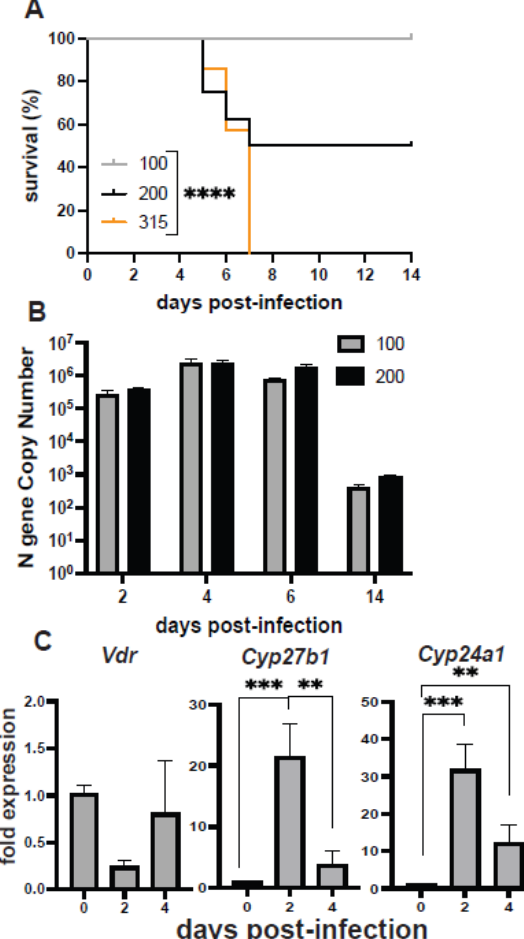
Figure 2. SARS-CoV-2 infection. K18-hACE2 mice were intranasally inoculated with 100 ( n = 8), 200 ( n = 8), and 315 ( n = 7) TCID 50 of SARS-CoV-2 virus. Mice were sacrificed when they met pre-determined endpoints (worsening conjunctivitis, lethargy, labored breathing, and/or dehydration) or at day 14 post-infection. ( A ) Mice were monitored for survival until day 14 post-infection. Mice were euthanized, and lung tissue was collected for ( B ) SARS-CoV-2 N gene expression at days 2–14 post-infection, ( C ) Vdr, Cyp24A1 , and Cyp27B1 mRNA gene expression ( n = 4/group/timepoint) at day 0, day 2, and day 4 post-infection in the lung. Samples were normalized to uninfected control tissue. Values are the mean ± SEM. Statistical significance was assessed using log-rank test for trend ( A ), two-way ANOVA model for main effects only for ( B ), and one-way ANOVA with Bonferroni multiple comparison test on log-transformed expression values for ( C ). ** p < 0.01, *** p < 0.001, and **** p < 0.0001.